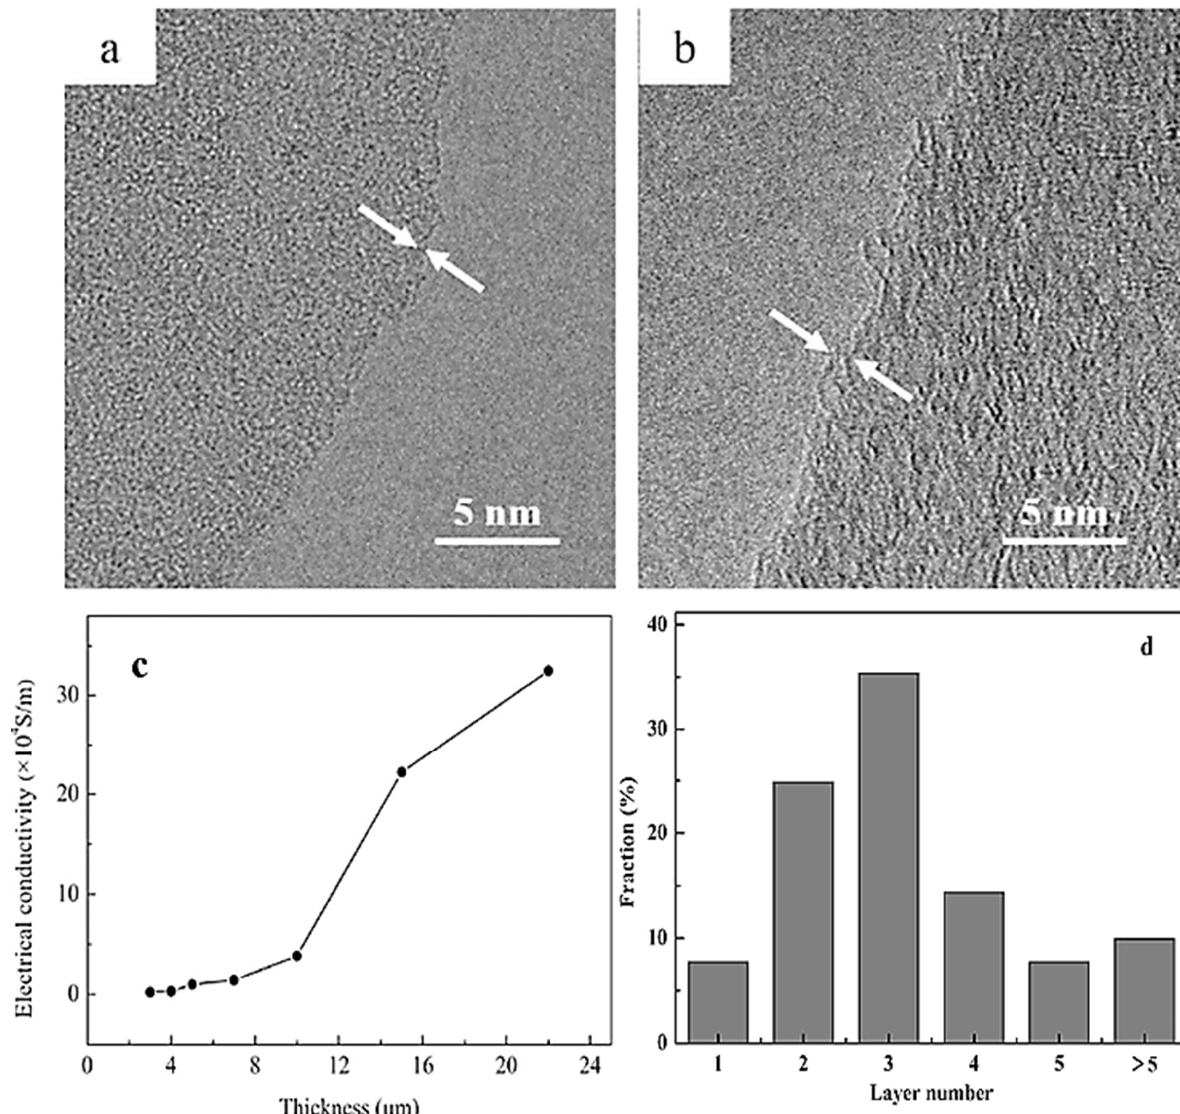
Figure 7. HR-TEM micrographs of ( a ) single-layer and ( b ) double-layer graphene; ( c ) electrical conductivity vs. sample thickness; and ( d ) presentation of graphene % in the form of histogram as a function of number of layers counted using AFM. Adopted with permission from [75].